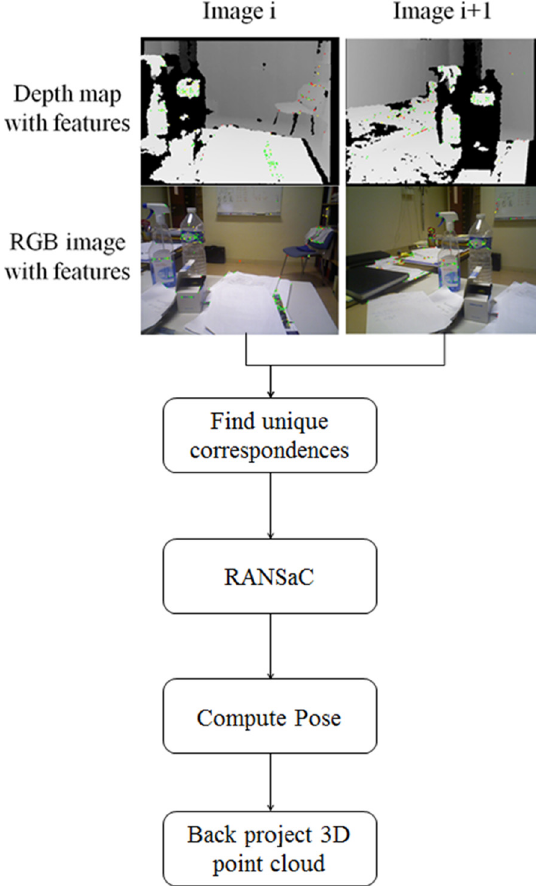
Fig. 3. Visual odometry processing.